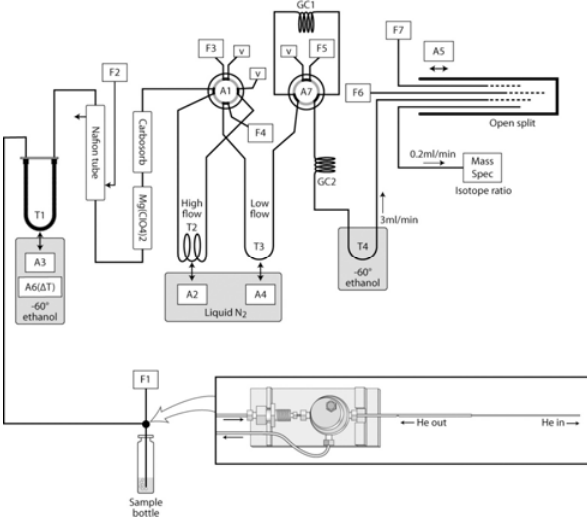
Figure 2. Purge and trap system: T = trap, A = automation controlled by Isodat, F = flow controller, GC = gas chromatogram, V = vent to atmosphere. Inset: custom concentric needle design using the CombiPAL 1 mL syringe holder. Gas flow paths are indicated by arrows. Please refer to text for additional details. Reprinted with permission from Ref. [31]. Copyright 2011 ACS.